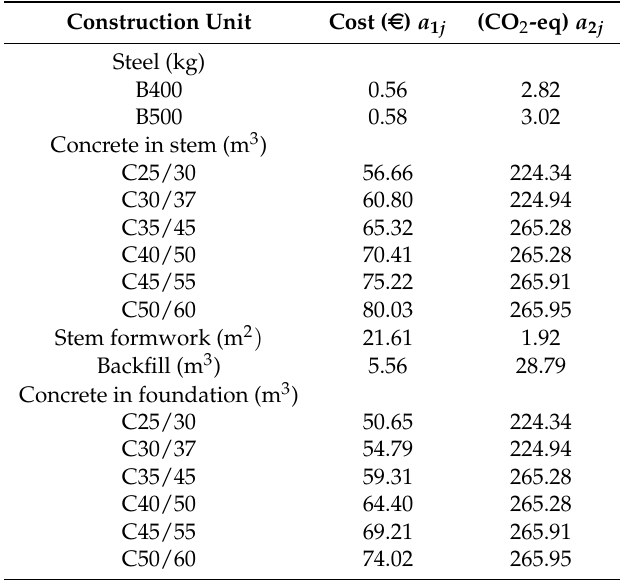
Table 1. Values per unit of cost and emissions